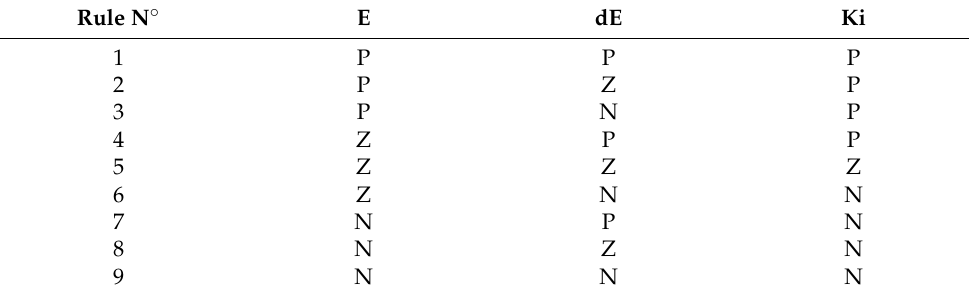
Table 5. Inference rules for